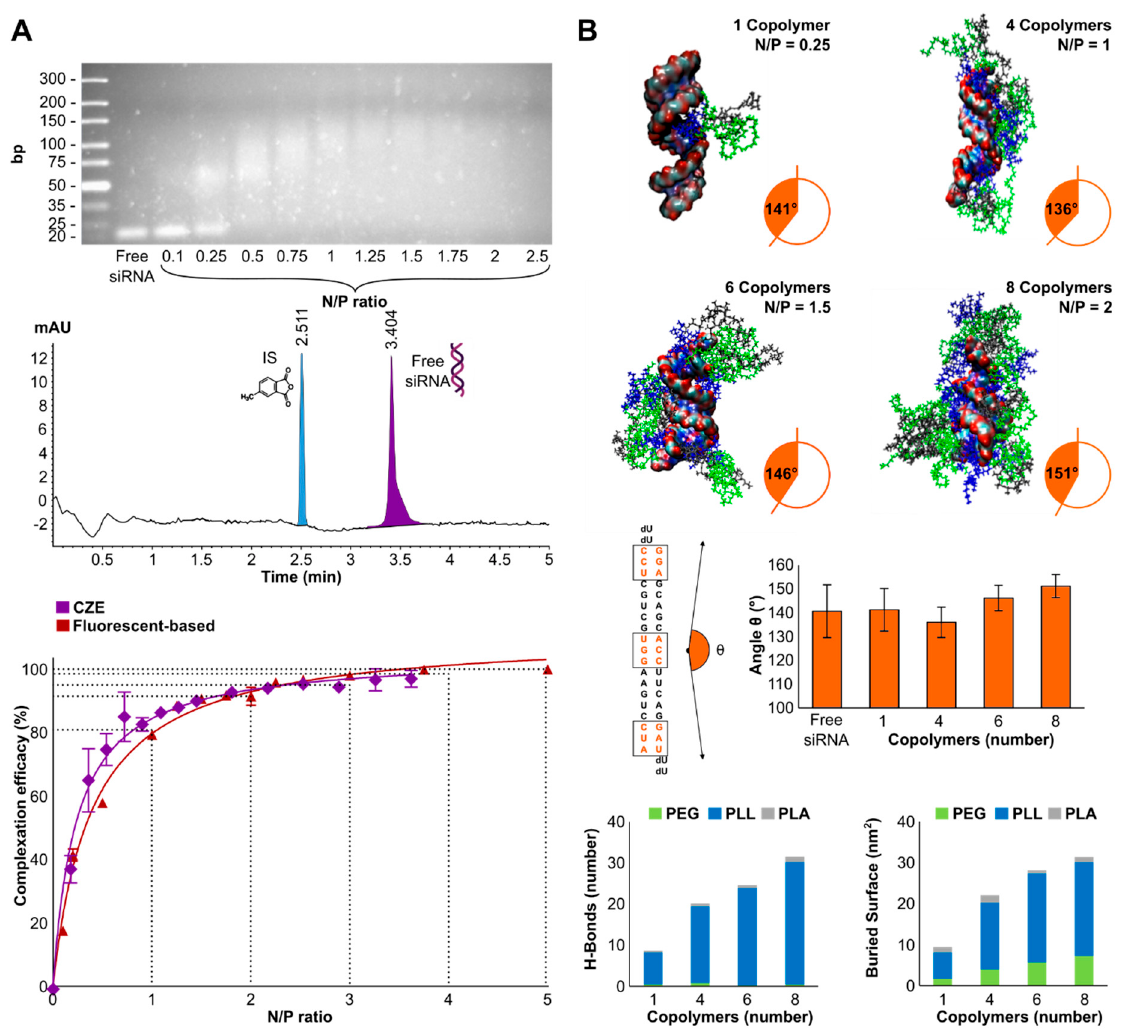
Figure 2. ( A ) Binding properties of triblock copolymeric micelles and STAT3-siRNA run on 4% gel agarose electrophoresis. Typical electropherogram (260 nm) of a standard solution containing 2 µ M STAT3-siRNA and 4 µ g/mL of the internal standard (IS). Percentage of the complexed siRNA versus the N/P ratio obtained by RiboGreen assay (claret) and capillary electrophoresis (purple) (n = 3). ( B ) Molecular conformation of the complexes by addition of triblock copolymers. Along the filament axis, the angle θ is calculated connecting the nucleotides located at the center of mass and the ending nucleotide bases highlighted in orange. The contribution to the complexation of the polymeric segments PEG, PLL, PLA involved in the complex formation was estimated by calculating the H ‐ bond numbers and the total buried surfaces.